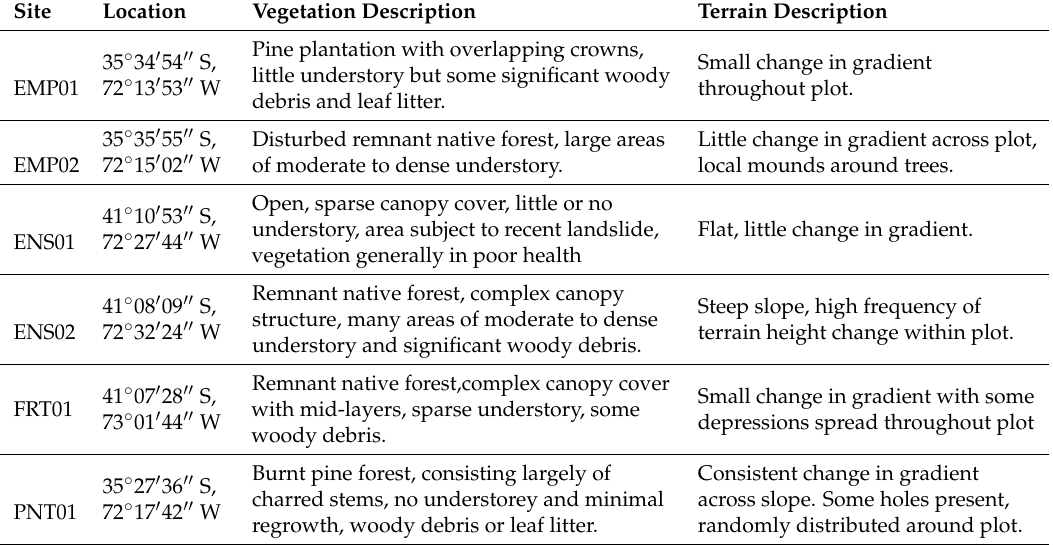
Table 1. Site description of Chile